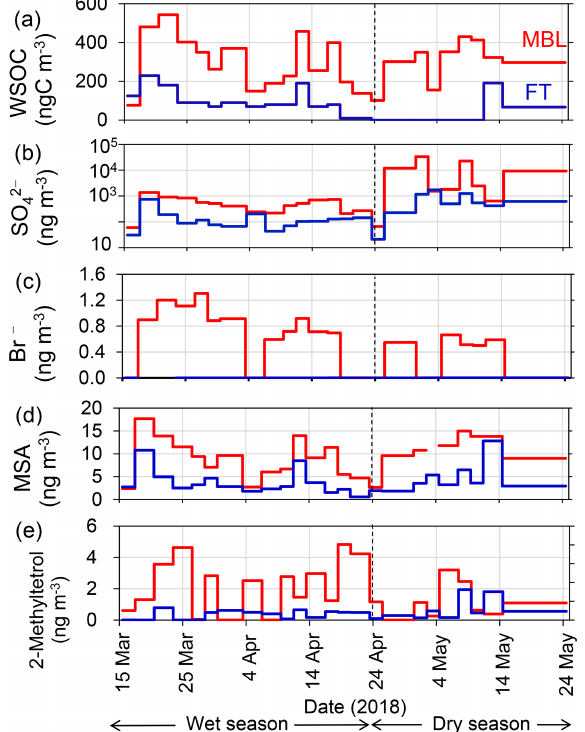
Figure 4. Time series of the mass concentrations of (a) WSOC, (b) sulfate, (c) bromide, (d) MSA, and (e) 2-methyltetrol under the MBL (red) and FT (blue) conditions.